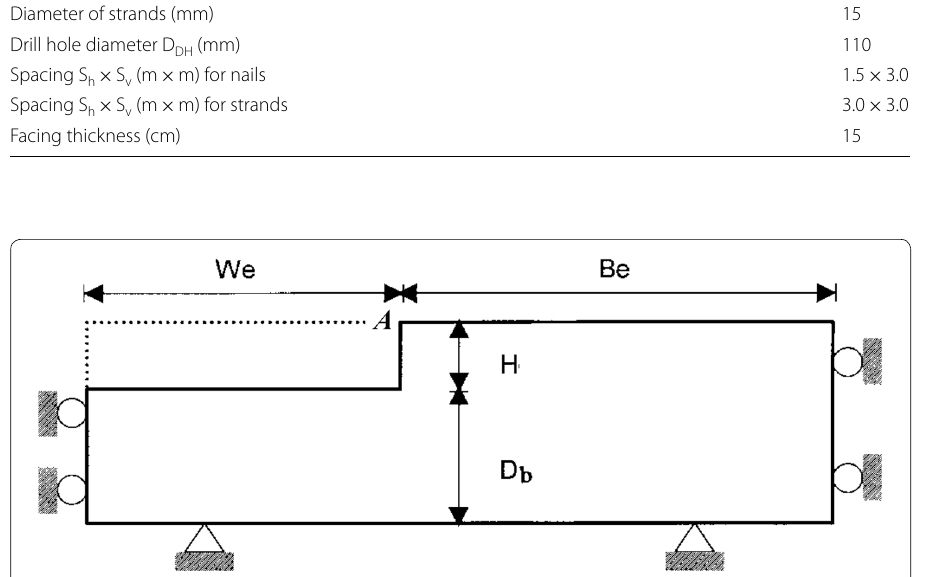
Fig. 2 Definition of W e , B e , and D